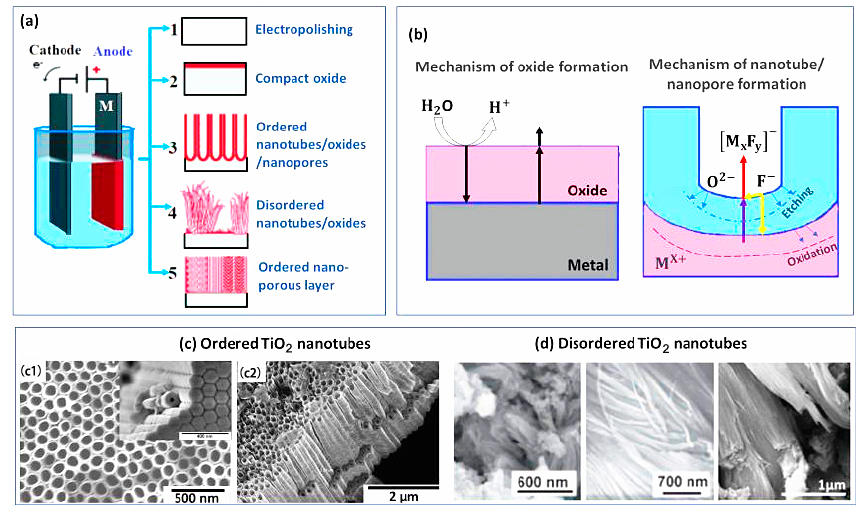
Figure 13. ( a ) The fabrication of various topographies on metallic substrates by the anodization method; ( b ) the mechanism of oxide, nanotube, and nanopore formation by anodization; ( c1 ) and ( c2 ) ordered TiO 2 nanotubes [146]; ( d ) disordered TiO 2 nanotubes [147] (reproduced with permission number: 5071091497388, Elsevier).